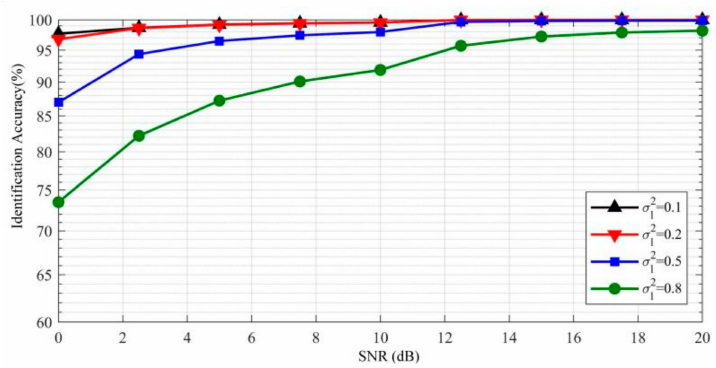
Figure 8. Identification accuracy against SNR under different turbulence